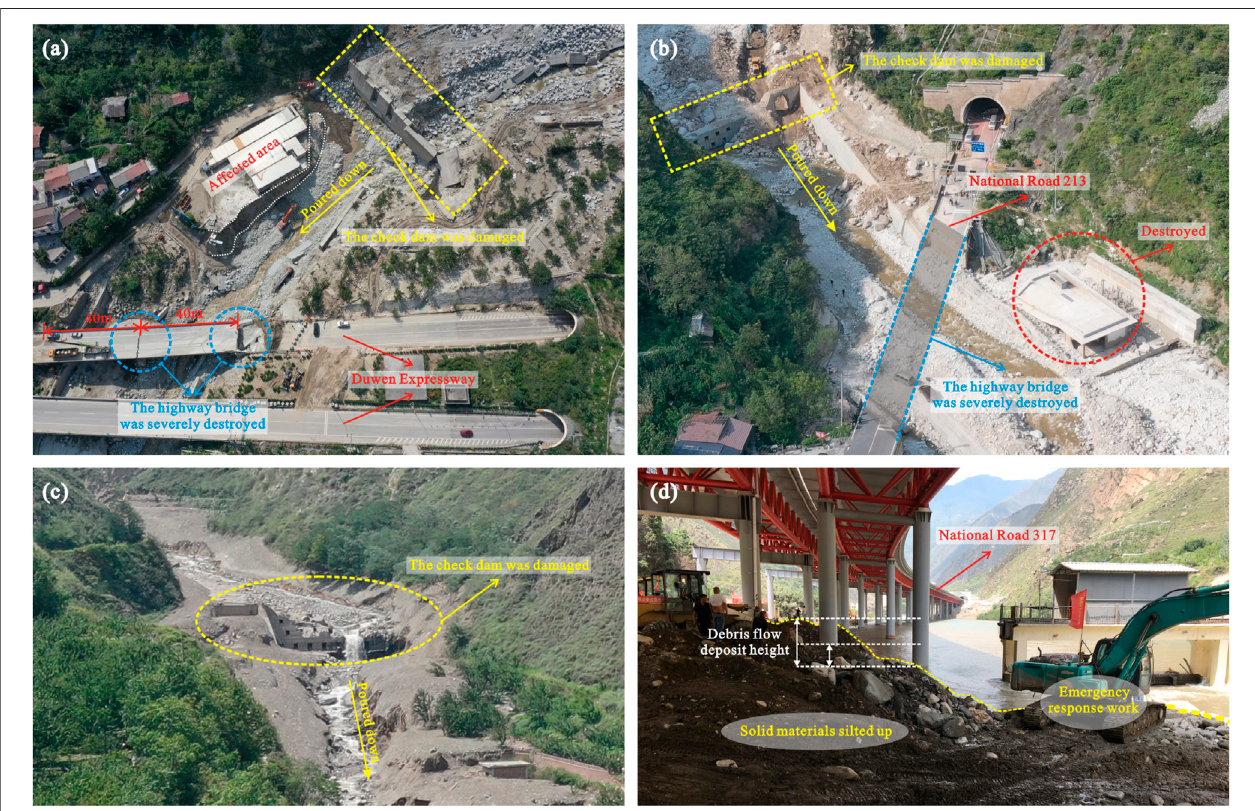
FIGURE9| Typicaltracesofengineeringfacilitydamagecausedbythe “ 8 · 20 ” clustereddebris fl owsevent: (A) damagetothecheckdamandbridgepiercolumns in Banzi Gully; (B) damage to the check dam and highway bridge in Dengji Gully; (C) a destroyed check dam in Chayuan Gully; and (D) abundant solid materials deposited at the highway bridges and